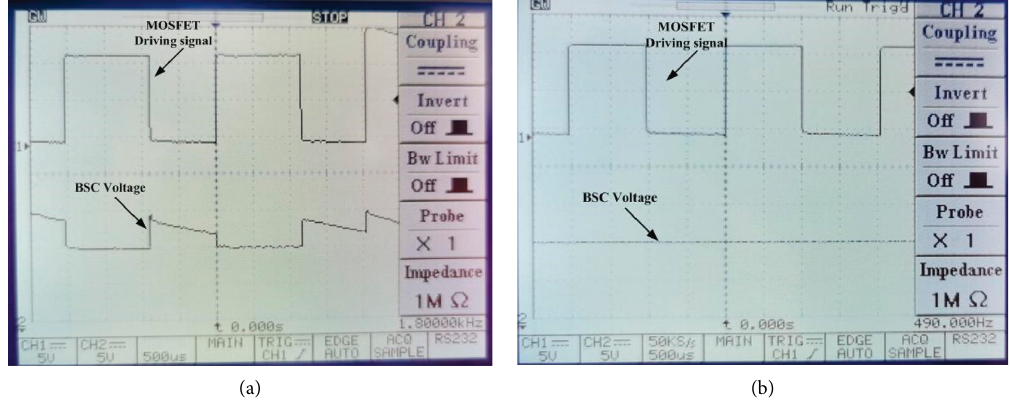
Figure 16: Charging and discharging of the BSC (500Hz, D � 0.5).